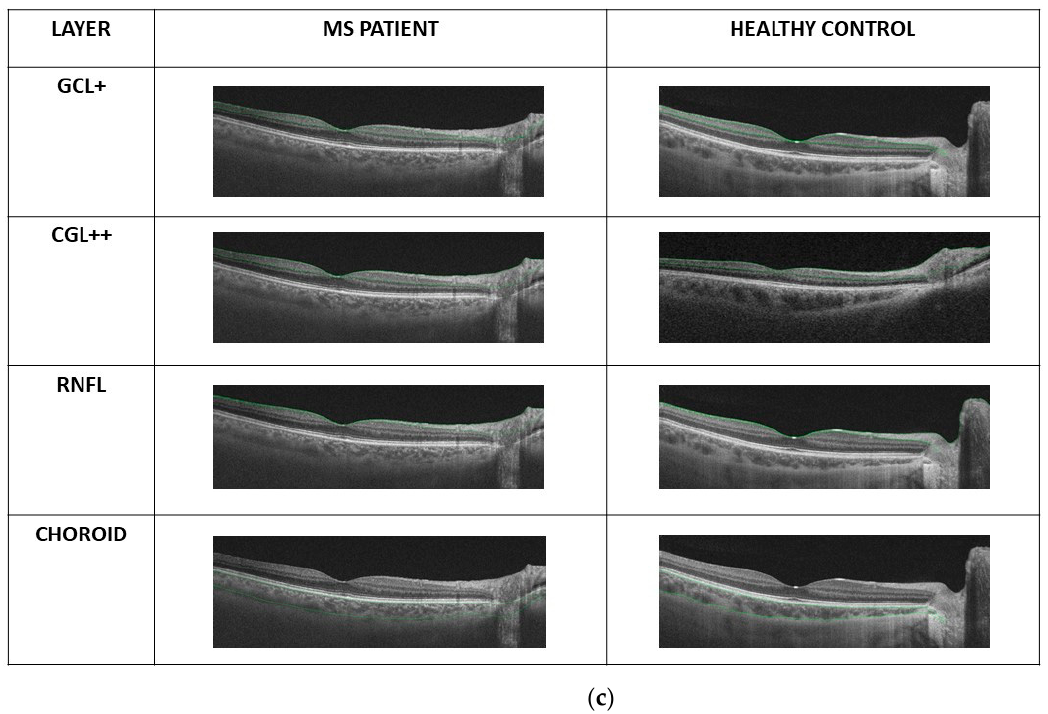
Figure 1. ( a ) Retinal layer measurements analyzed: RNFL, GCL+, GCL++, complete retina and choroid; ( b ) OCT scanning source slice image of a normal eye showing, in green, the boundaries of the layers into which the software segments the neuroretina image and the representation of the complexes measured; ( c ) representation of delimitation of the four retinal layers determined by the segmentation software of Triton OCT (optical coherence tomography) in a patient with multiple sclerosis and in a control subject: GCL+ (ganglion cell layer +: between the boundaries of the retinal nerve fiber layer and the inner nuclear layer, therefore including the GCL and the inner plexiform layer), GCL++ (between the boundaries of the inner limiting membrane and the inner nuclear layer, therefore including the retinal nerve fiber layer and the GCL+), RNFL (retinal nerve fiber layer: between the boundaries of the inner limiting membrane and the GCL) and CHOROID (from Bruch’s membrane to the choroidal-scleral interface).